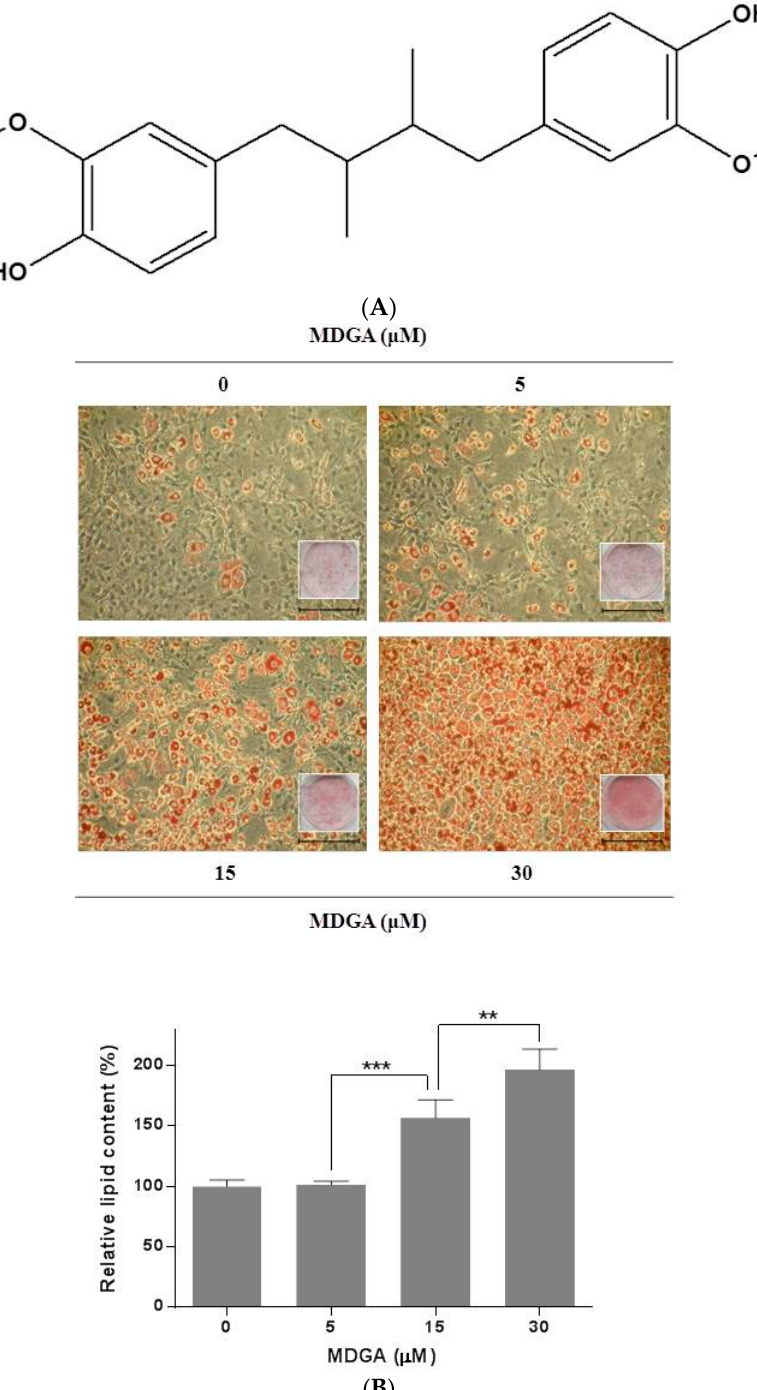
Figure 1. Stimulatory effect of MDGA on adipocyte differentiation. ( A ) Chemical structure of MDGA; ( B ) 3T3-L1 preadipocytes were stimulated with a mixture of adipogenic inducers containing 0.1 µ g/mL insulin, 0.5 mM IBMX, and 1 μ M dexamethasone. Cells were treated with MDGA (0, 5, 15, or 30 µ M) every other day during the first 4 days of differentiation. On day 6, cells were stained with Oil Red O, visualized under a light microscope, and the intensities were quantified. All values are presented as the mean ± SD of three experiments performed in triplicate. Statistical significance: ** p < 0.01, *** p < 0.001.